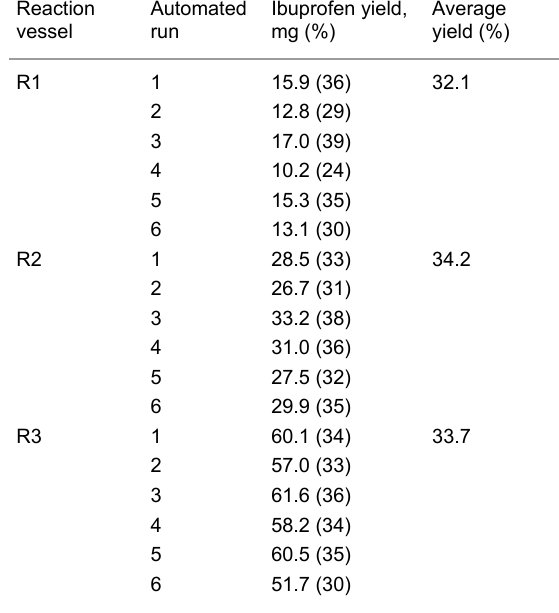
Table 3: Isolated ibuprofen yields for automated